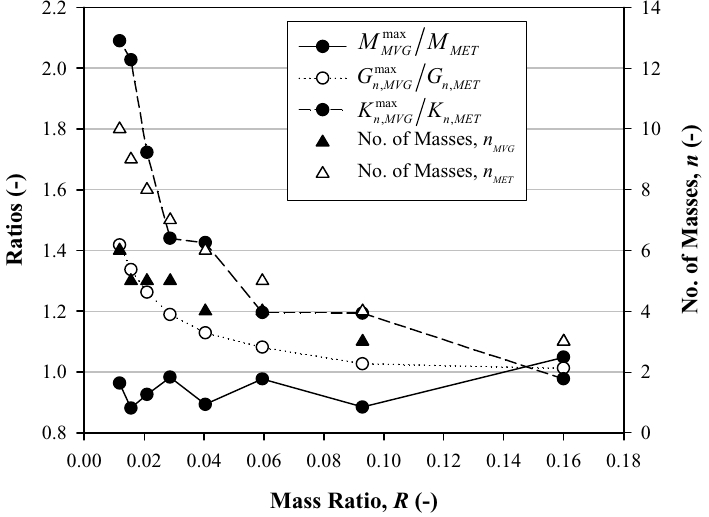
Fig. 18. Comparison of total system mass, velocity gain and kinetic energy transfer efficiency for MET and MVG systems with e = 0 . 8 . Note that the number of masses for the MVG system has been optimised. (-) means non-dimensional. these shock amplification machines, and comparisons with theory, will be published in upcoming